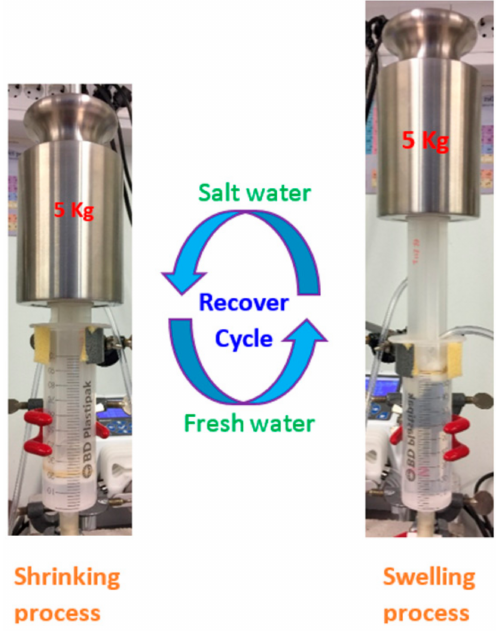
Figure 1. Illustration of a cycle of the energy recovery process. Hydrogels were fully swollen in de-ionized water for at least 15–20 days before initiating the measurements. The fully swollen gel (60 g) was placed in the syringe and a load weight of 5 kg was applied on the top of the plunger. The high salinity solution was pumped at a rate of 3 mL/min from the bottom of the syringe through the hydrogel. The excess flow-out solution was pumped out at the holes of the plunger. When the plunger had moved downward to the minimum volume due to the shrinking of the hydrogel, the system was exchanged to pumping de-ionized water at a rate of 5 mL/min. The flow rate was controlled by peristatic pumps (Reglo ICC, Ismatec, Cole-Parmer GmbH, Ismatec, Wertheim, Germany). The hydrogel swells, lifting the 5 kg weight to the maximum level. Each cycle, including one shrinking and one swelling, lasted for one hour. The cycles were repeated 6 times in a day. The experiments were carried out for 5 consecutive days for a total of 30